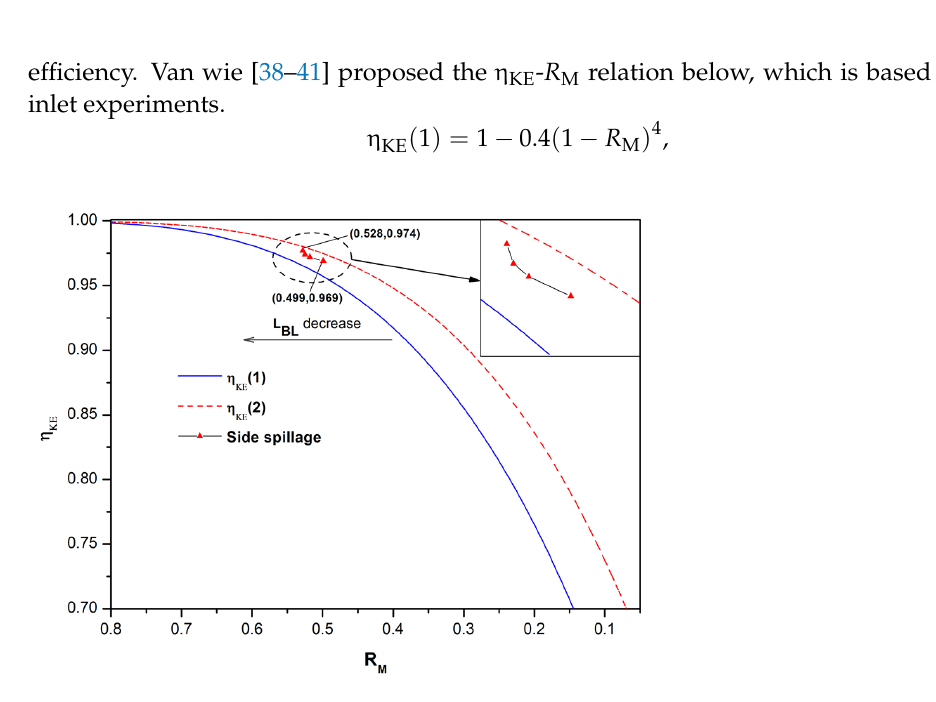
Figure 17. Inlet efficiency based on different boundary layer thicknesses.